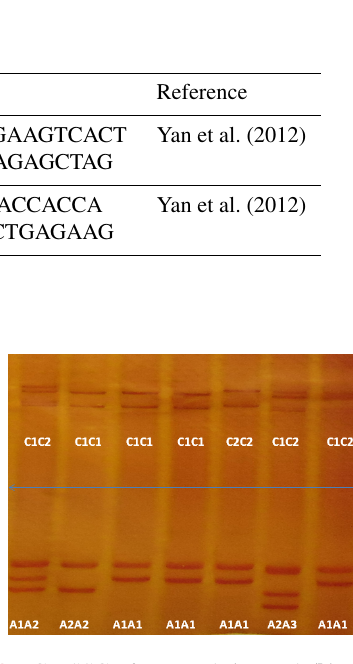
Figure 1. PCR-SSCP for exon 2–intron 2 (b) and exon 3–intron 3 (a) of the FABP4 gene in Sfakia